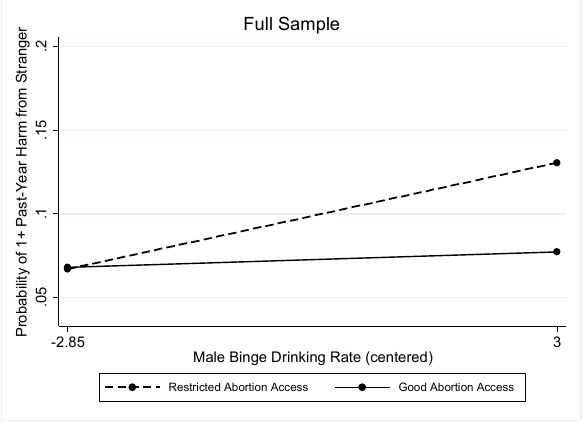
Figure 3. Interaction between the male binge drinking rate and abortion rights in relation to stranger-perpetrated harm in the full sample.